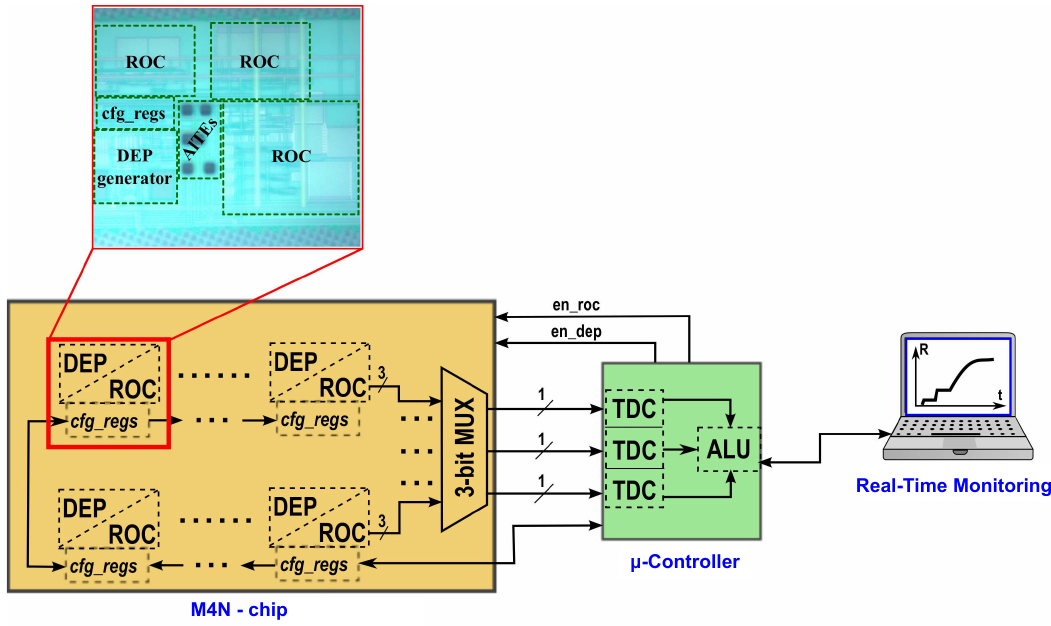
Figure 5. The block diagram of the whole system for nanosensing. The microcontroller-based platform is used to configure the M4N array, to convert the quasi-digital outputs to N-bit values using Time-to-Digital Converters (TDCs) and to redirect the elaborated data to the workstation in real-time. ALU: Arithmetic Logic Unit, cfg_regs: configuration registers of the M4N